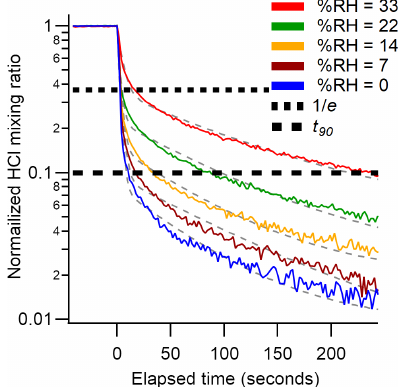
Figure 4. Background corrected and normalized signal decay curves observed for pulsed HCl (24ppbv) performed at various RHs. Dashed grey lines represent a double exponential fit to the average of three cycles at each water mixing ratio. The short and long dashed black lines indicate 37% (1 /e ) and 90% ( t 90 ) decrease from the initial signal,